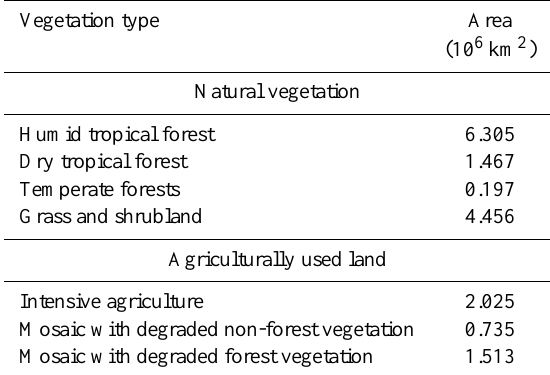
Table 2. Vegetation cover of South America in 2000 AD a